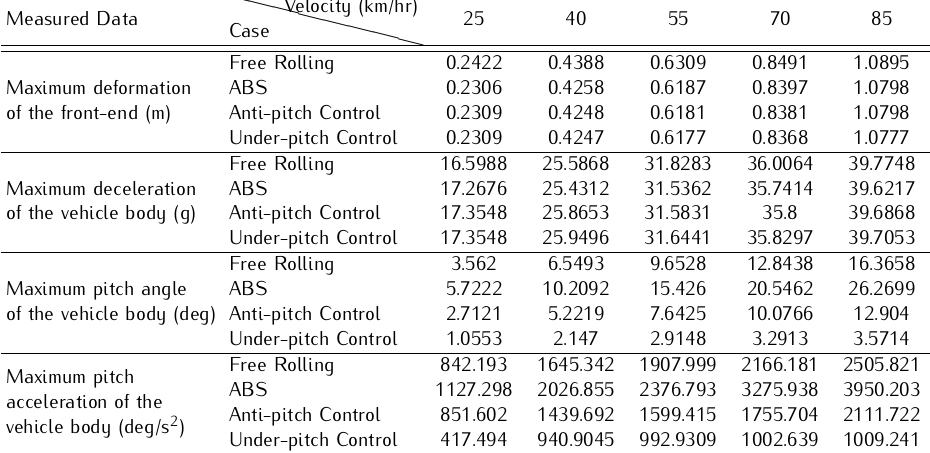
Table 2. Numerical results of a full frontal crash scenario VDCS and different five speeds.